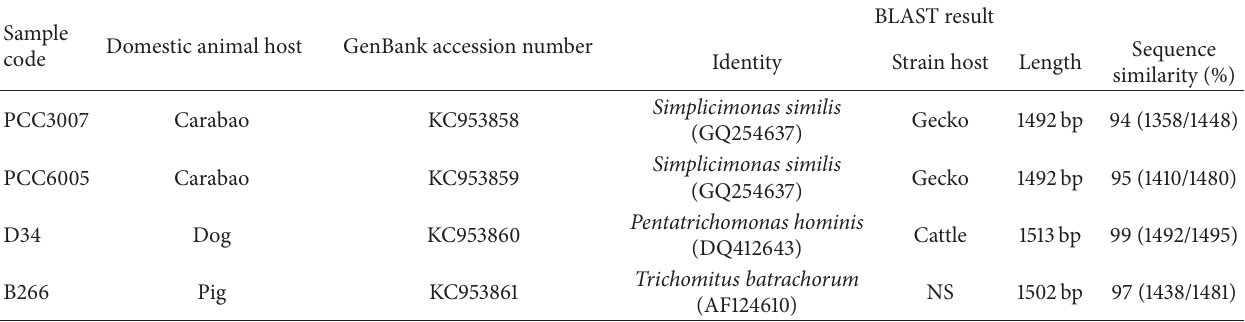
Figure 1: Phylogenetic tree of trichomonad isolates and reference gene sequences using maximum likelihood analysis. The tree was rooted on Trichonympha agilis . The values on the nodes are bootstrap support from maximum likelihood and neighbor-joining analyses, respectively. Bootstrap support lower than 50% is not shown. ∗ : weak support; ∗∗ : branch not observed in NJ tree. Table 1: Trichomonad isolates and their respective homologous sequences from NCBI BLASTN query search and percent homology to DNA